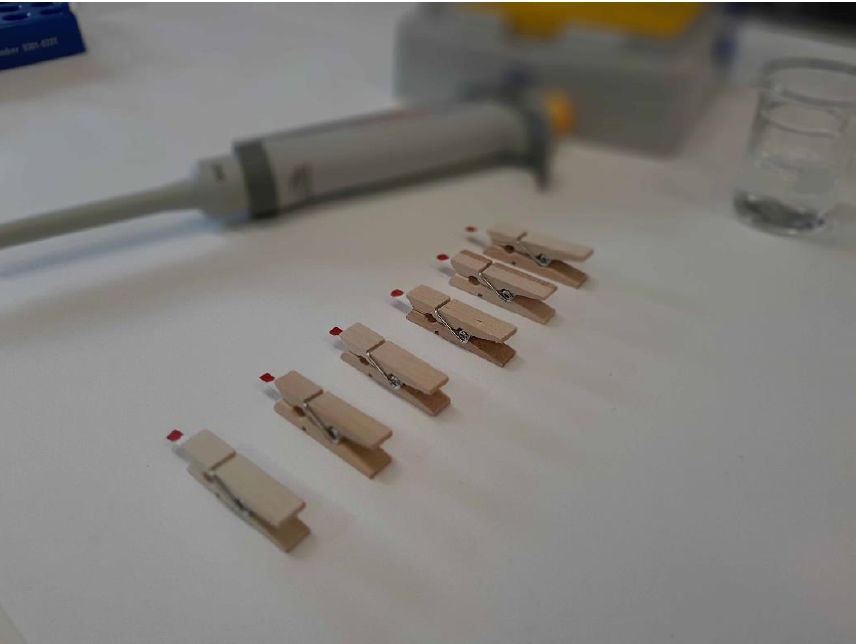
Figure 2. DBS homemade support; the wooden clothespin allows the blood deposited on the paper to dry uniformly and avoid any contact with the bench. Samples can be cut and placed in Eppen- dorf vials simply by using the clips as a handle.